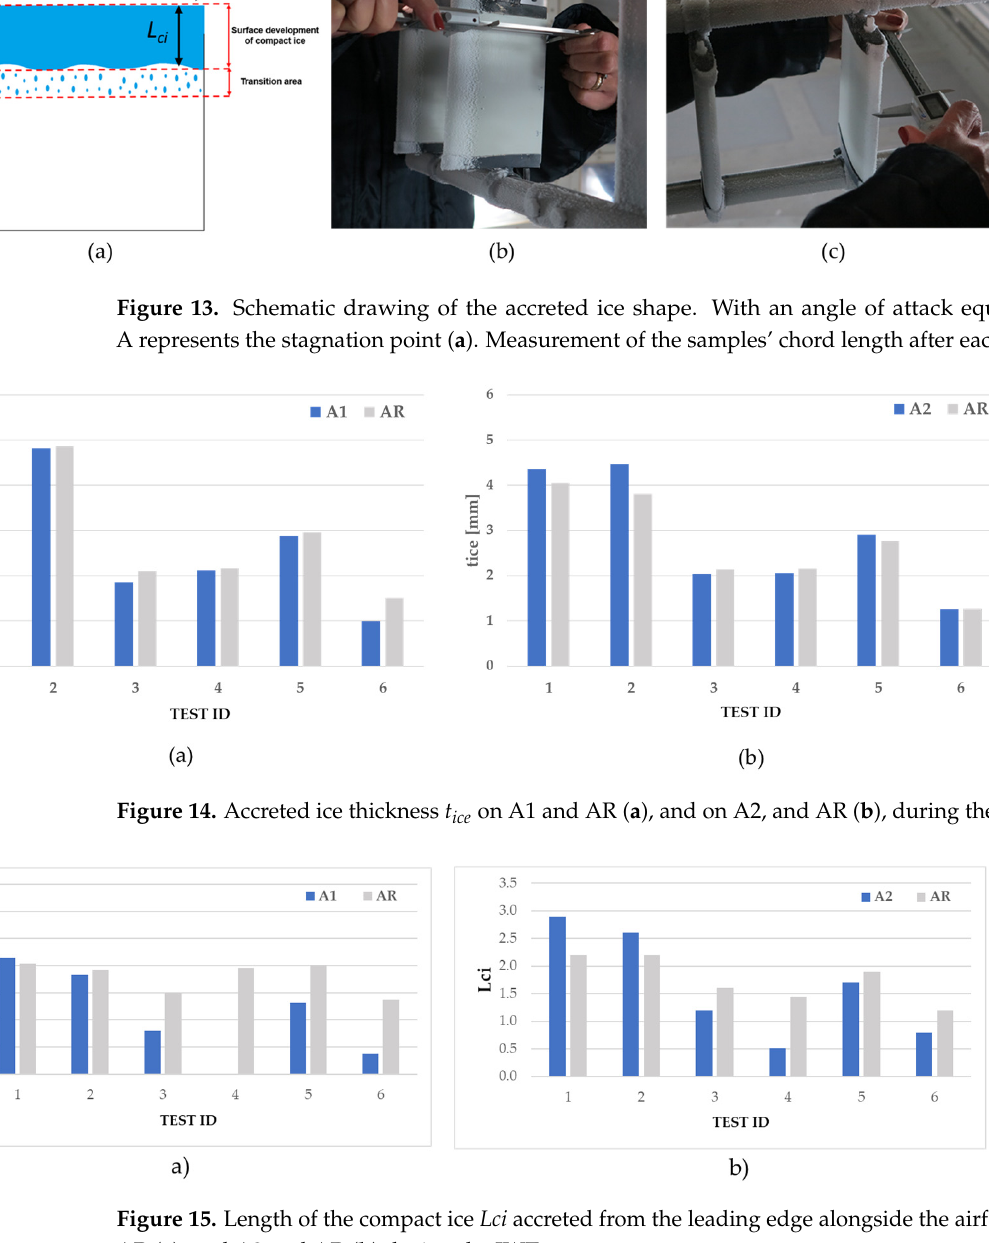
Figure 15. Length of the compact ice Lci accreted from the leading edge alongside the airfoils A1 and AR ( a ), and A2 and AR ( b ) during the IWT